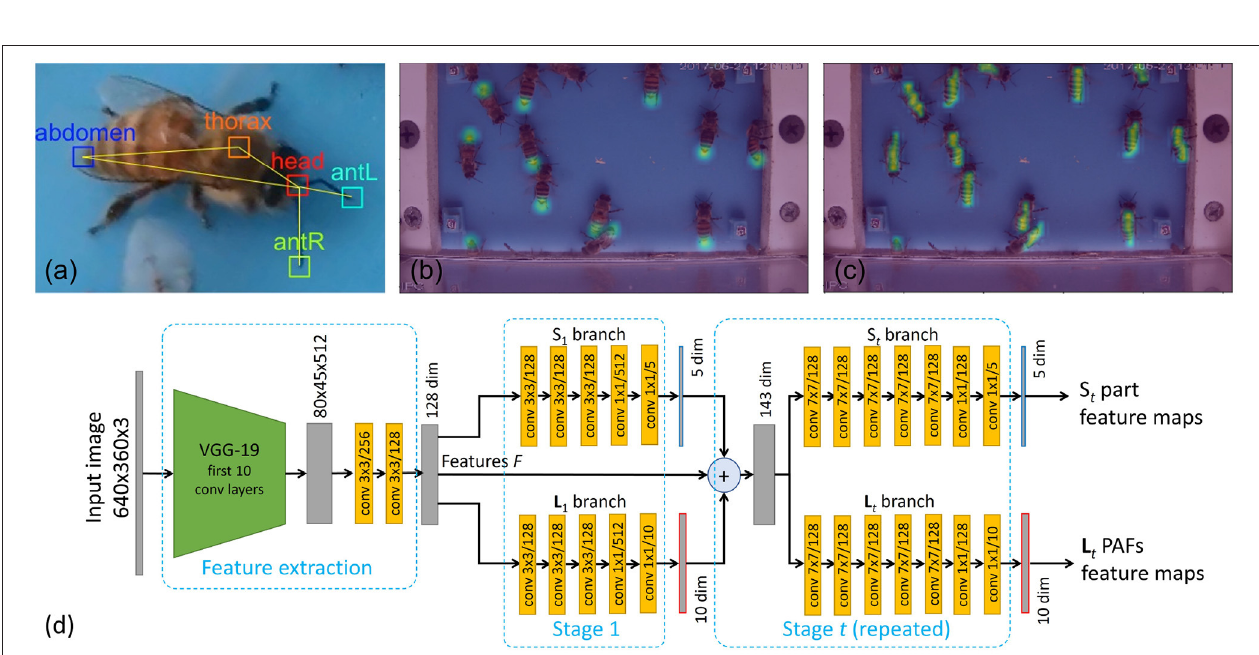
FIGURE 3 | Pose detection model. (a) 5 parts skeleton (Head, Thorax, Abdomen, Left and Right Antenna) and connection used. (b) Confidence map of the abdomen keypoints used to train the (S) branch. (c) The magnitude of the Part Affinity Field (PAF) of the thorax-abdomen connection used to train the (L) branch. (d) Convolutional Neural Network architecture used to predict the body part confidence maps and PAFs organized as a feature extraction backbone followed by the two branches (S) and (L) with iterative refinement stages.